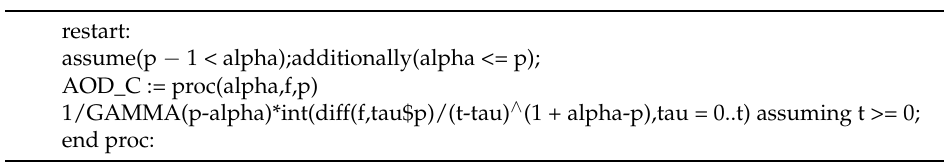
Table 5. Maple 18 code of